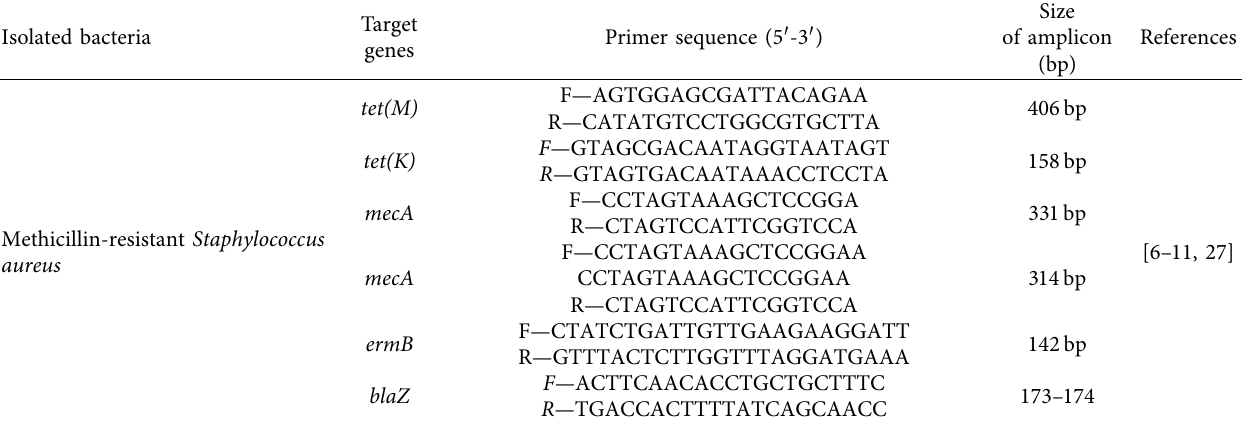
Table 2: PCR primers used to detect antimicrobial resistance genes in MRSA